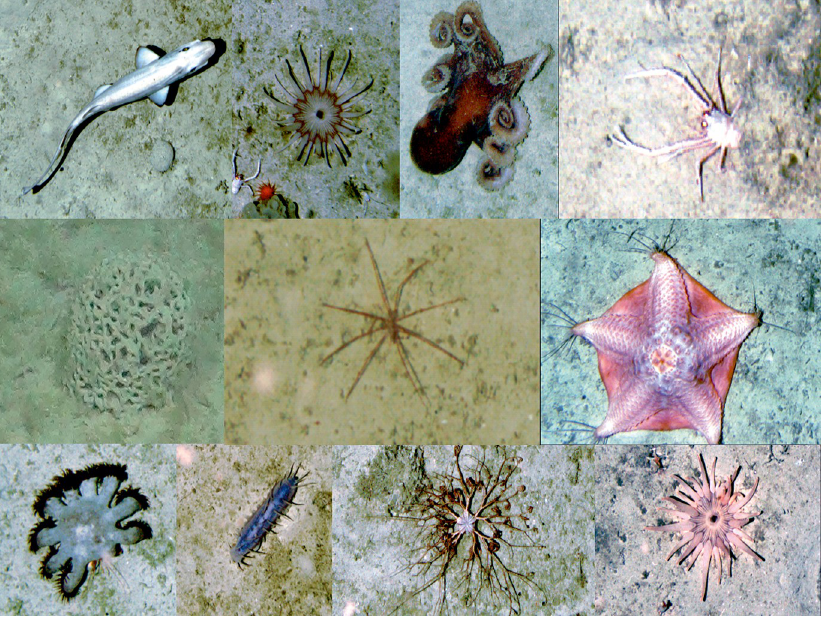
Fig 1. Example of a reference image catalogue where representatives of each taxa observed are cropped from an image, and assigned an OTU number that is subsequently used in image analysis in place of a standard latin